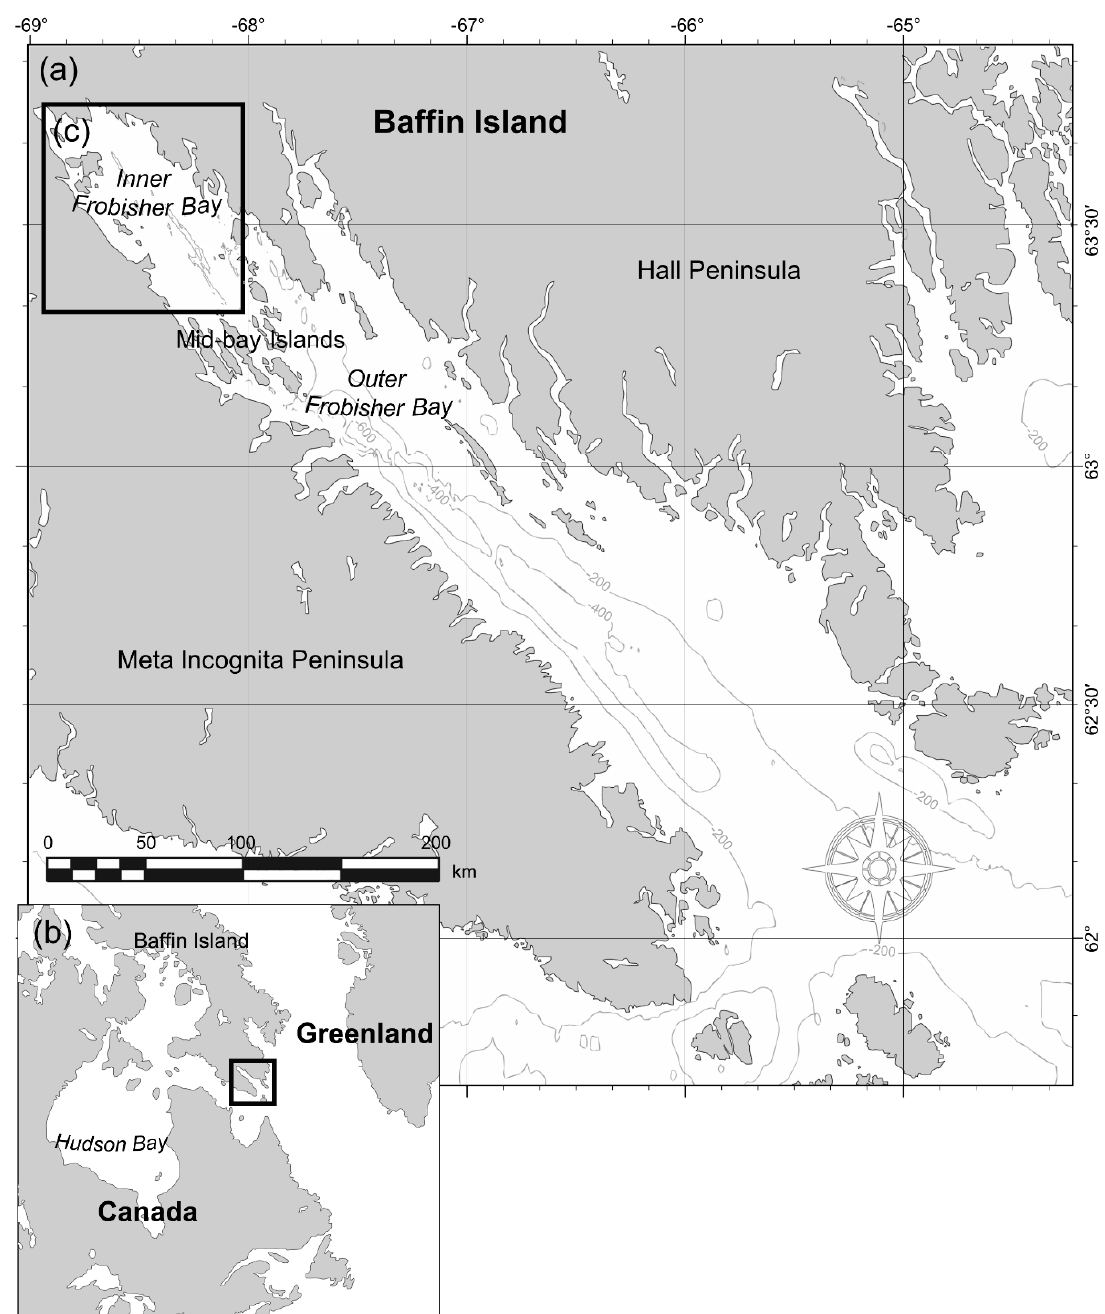
Figure 3. ( a ) Frobisher Bay, Nunavut, Canada with 200 m bathymetric contours from the GEBCO_2014 grid (The General Bathymetric Chart of the Oceans; [43]) and coastline reproduced from ESRI [44], with ( b ) location on southeastern Baffin Island and ( c ) the study area – inner Frobisher Bay.